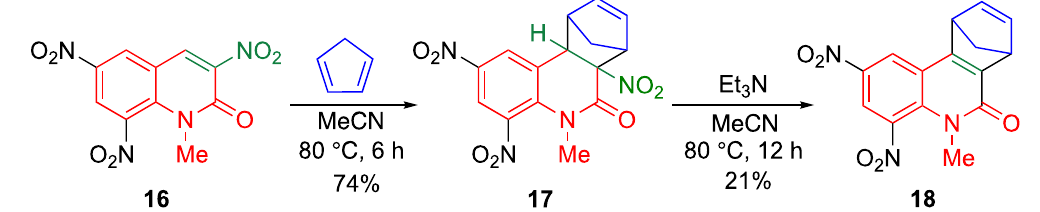
Molecules 2020 , 25 , x